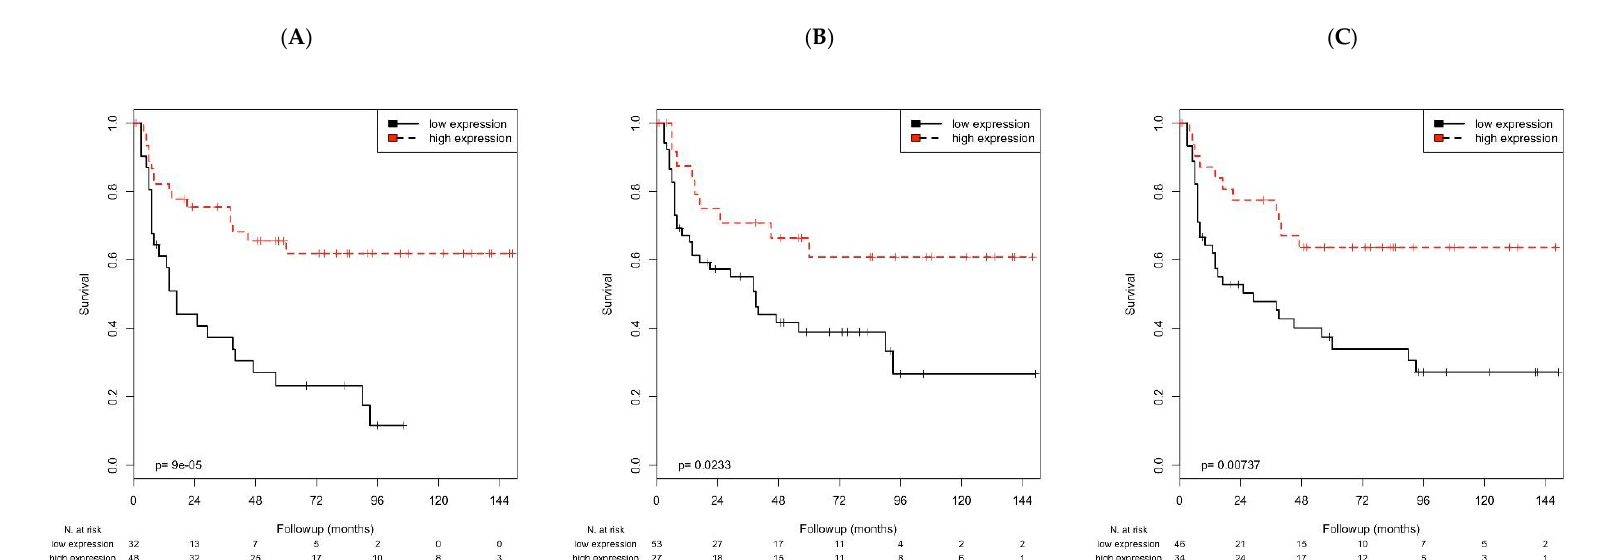
Figure 1. Kaplan–Meier analysis of the association of CXCL9 , PD1 or PD-L1 mRNA with RFS. Gene expression was significantly associated with RFS for the genes.